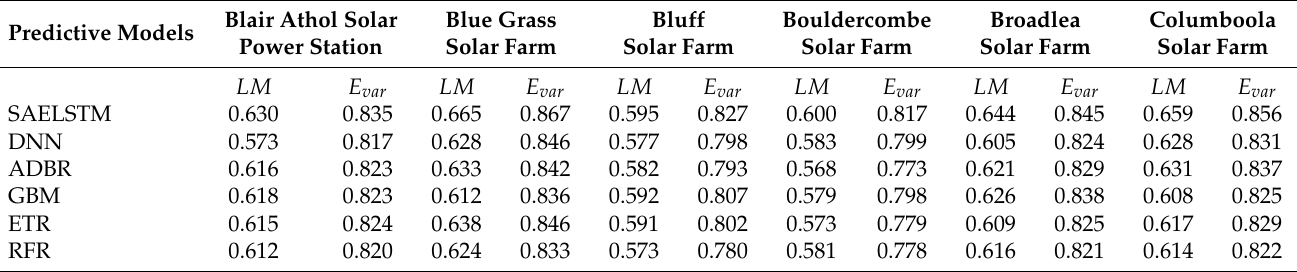
Table 6. As per Table 5 but measured in terms of the Legates and McCabes index ( LM ) and explained variance score ( E var